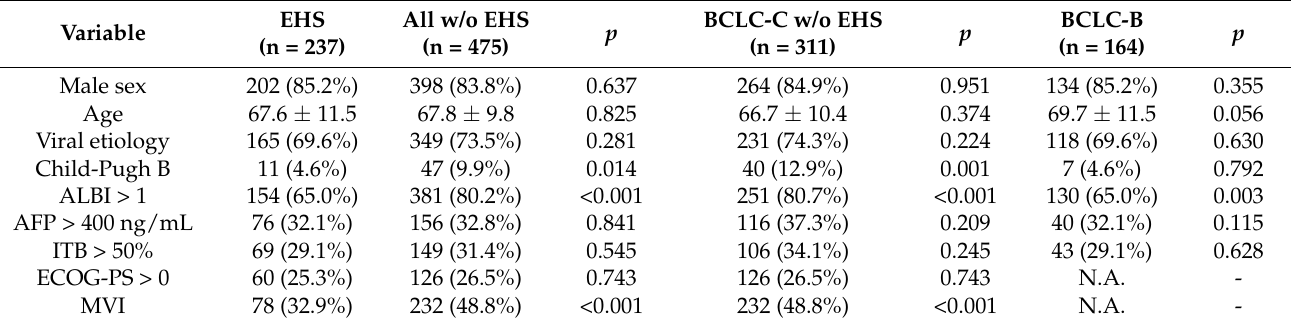
AFP: alfa-fetoprotein; ECOG-PS: Eastern Cooperative Oncology Group—Performance Status; ITB > 50%: intra- hepatic tumor burden > 50%; MVI: macrovascular invasion. N.A. not